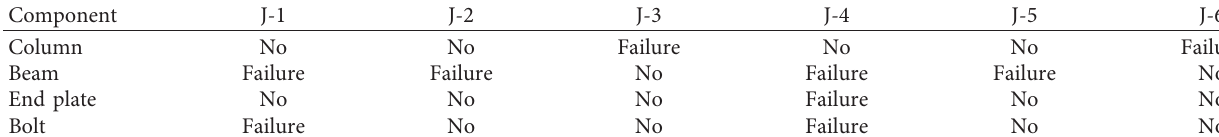
Figure 12: Failure modes of J-6: (a) column bending; (b) steel tube buckling; (c) steel tube fracture. Table 3: Failure components of the joints.